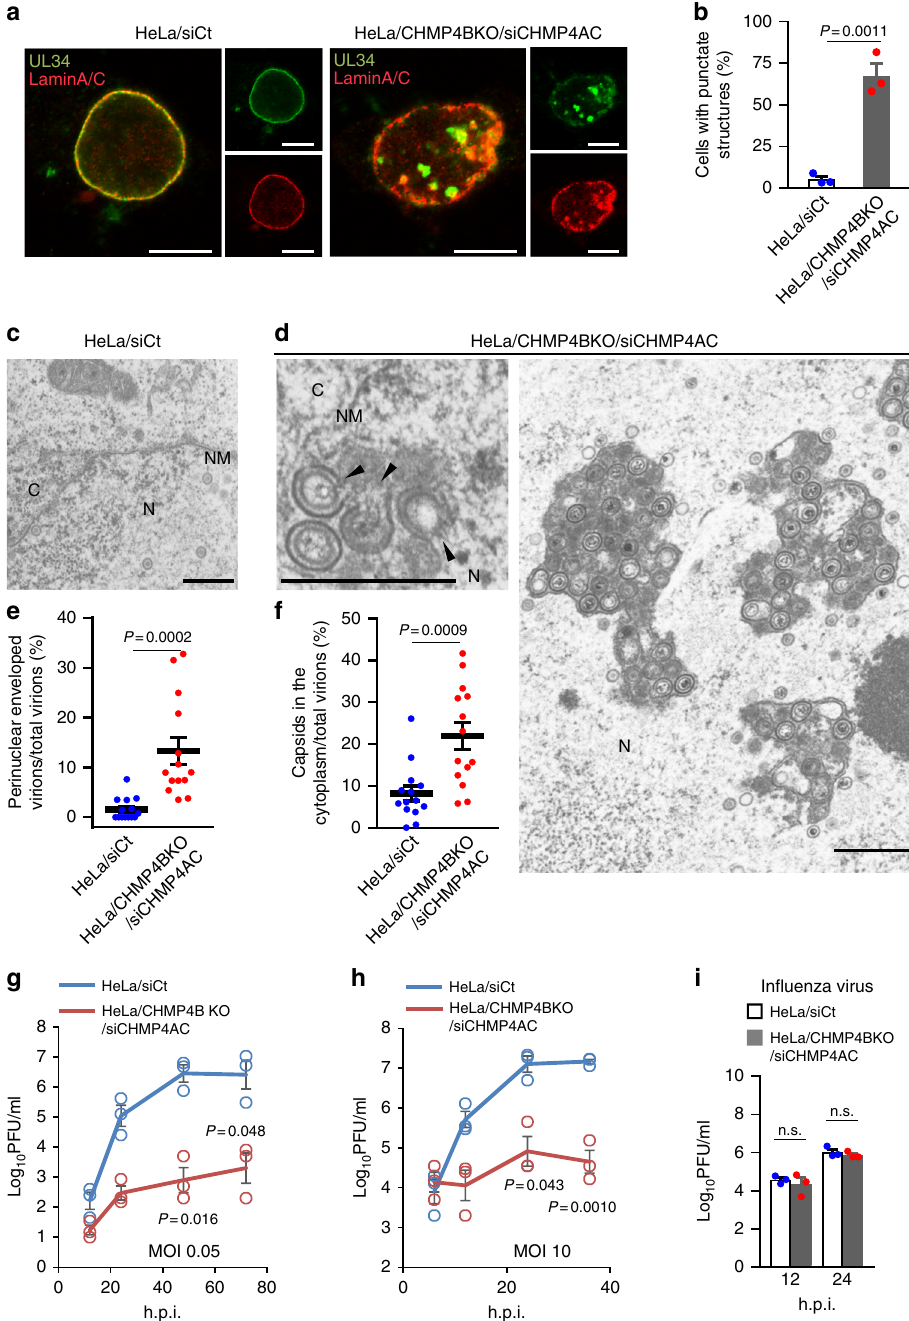
Fig. 3 ESCRT-III is required for proper nuclear egress of HSV-1. a Confocal microscope images of HeLa and HeLa/CHMP4B KO cells treated with (left) control siRNA (siCt) or (Right) siRNAs to CHMP4A and CHMP4C (siCHMP4AC), respectively, for 48 h, and subsequently infected with HSV-1 for 22 h. Bars, 20 μ m. Images are representative of three independent experiments. b Percent of cells (80 – 200 cells in each experiment) with aberrant punctate structures along with the nuclear rim in the experiment in ( a ). Data are shown as the mean ± SEM of three independent experiments. Electron microscope images of ( c ) HeLa and d HeLa/CHMP4B KO cells treated with siCt or siCHMP4AC, respectively, for 48 h and infected with HSV-1 for 22 h. Arrowheads indicate virions defective in the scission steps. C cytoplasm, N nucleus, NM nuclear membrane. Bar, 500 nm. Images are representative of three independent experiments. Percent of ( e ) perinuclear enveloped virions and f capsids in the cytoplasm of 14 cells in the experiments in ( c , d ). Data are shown as the mean ± SEM and are representative of three independent experiments. g – i HeLa and HeLa/CHMP4B KO cells treated with siRNA(s) as described in a were infected with HSV-1 at an MOI of ( g ) 10 or h 0.05, or with i in fl uenza virus at an MOI of 0.01, and progeny virus titers were assayed at the indicated hours post infection (h.p.i). Data are shown as the mean ± SEM of three independent experiments. The indicated P -values were obtained using the unpaired Student ’ s t -test ( b , e – i ). n.s., not signi fi